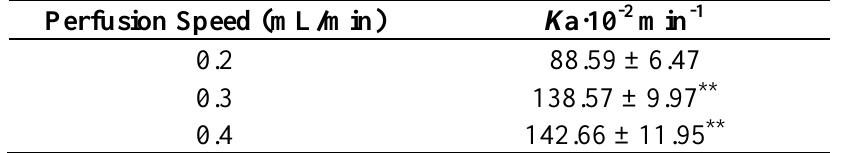
Table 1. K a of paeonol nasal absorption with different perfusion speeds ( n = 5, mean ± S.D.)